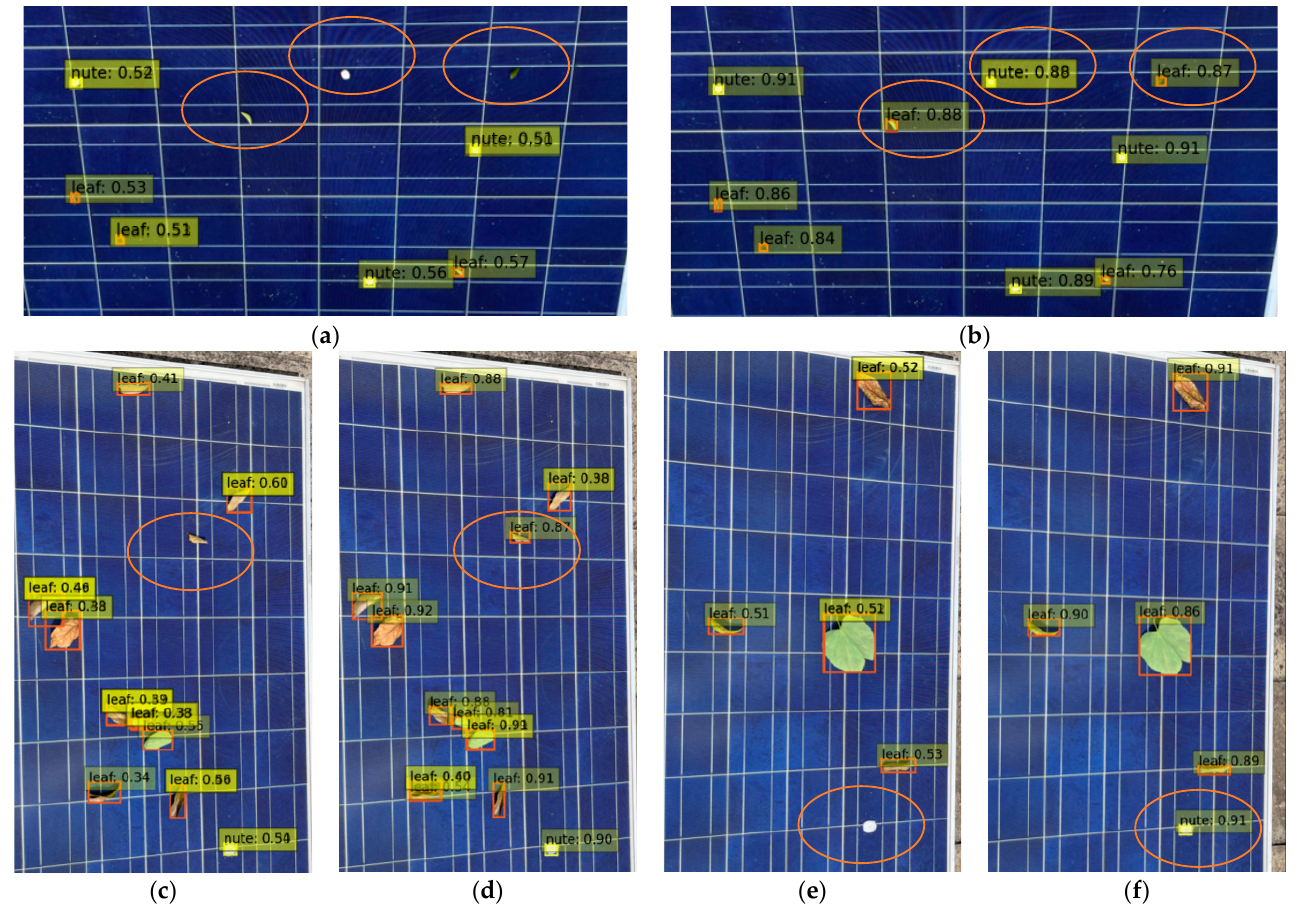
Figure 11. Target detection performance comparison. ( a ) Small target detection results before model enhancement; ( b ) Small target detection results after model enhancement; ( c ) Middle target detection results before model enhancement; ( d ) Middle target detection results after model enhancement; ( e ) Large target detection results before model enhancement; ( f ) Large target detection results after model enhancement.